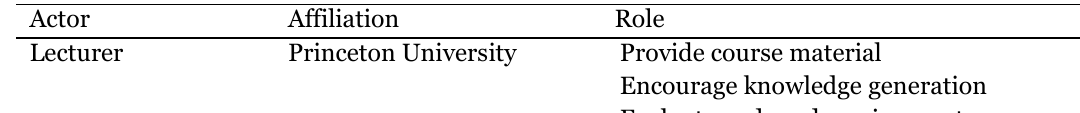
The GHL Course Learning